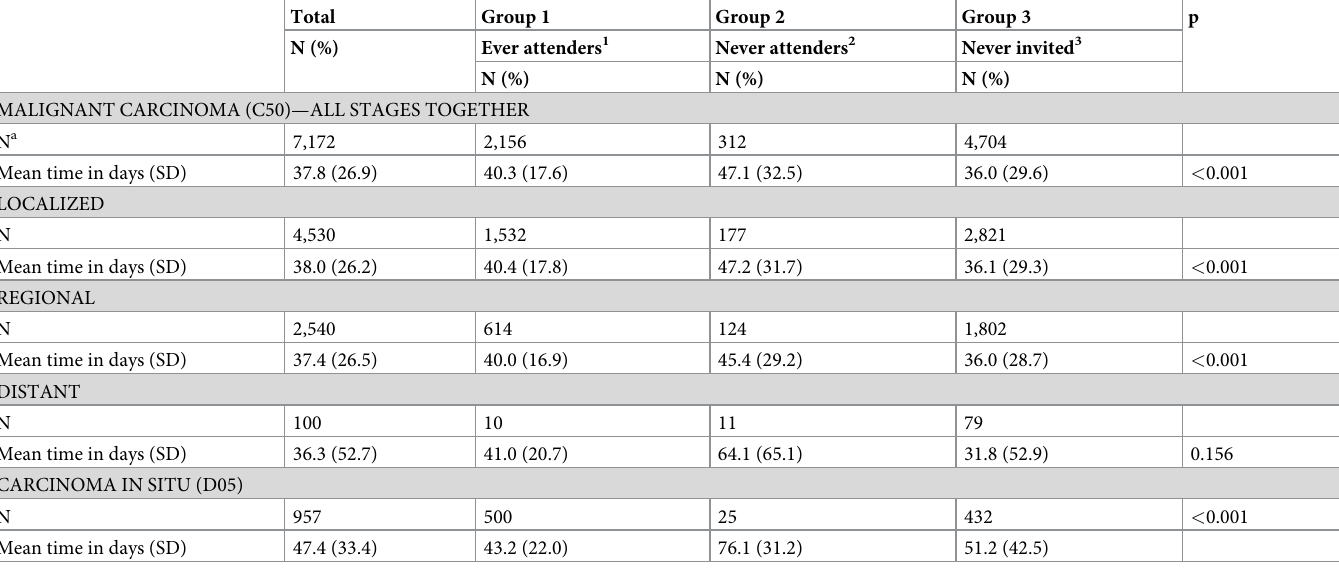
Table 1. Time from diagnosis of breast cancer to surgery as first treatment (number of cases in each group (N) and mean time in days with standard deviation (SD)) in women aged 50–74 years, by stage at diagnosis and screening programme status, Slovenia,